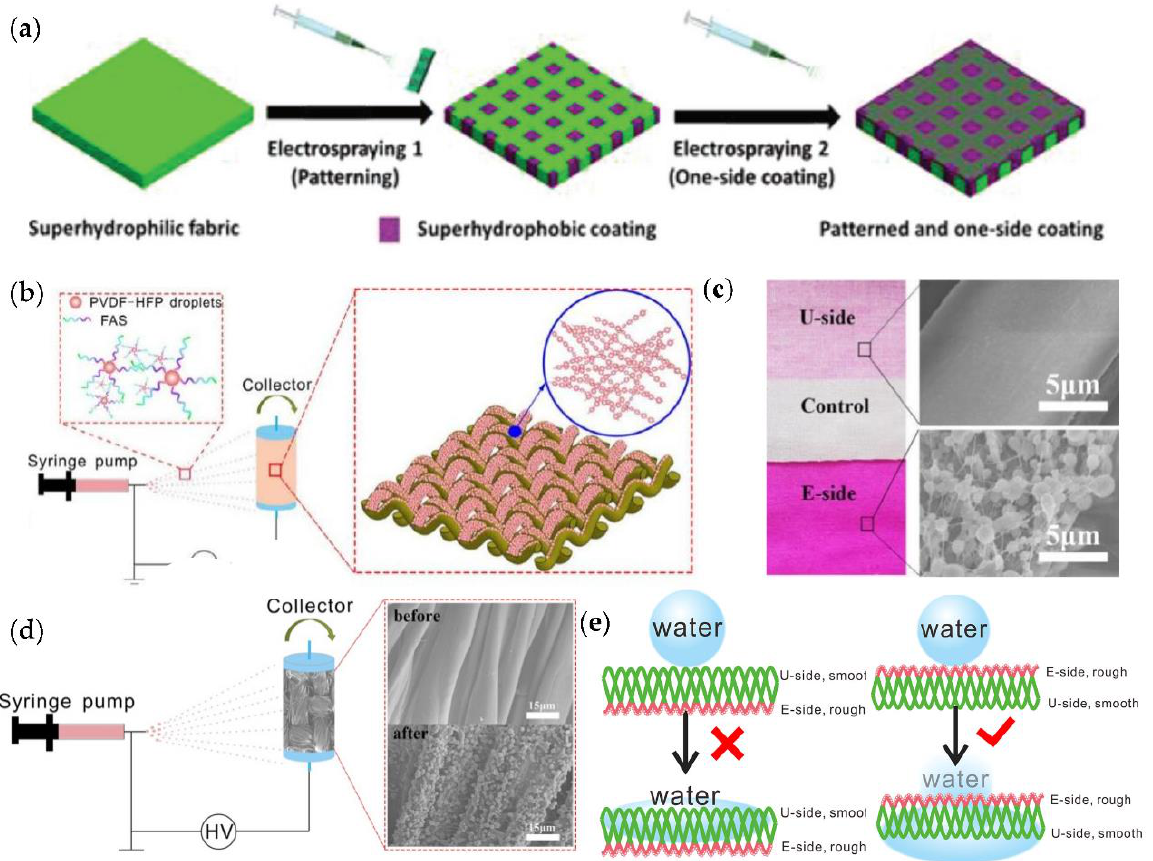
Figure 5. ( a ) Schematic illustration for the fabrication of a DWT fabric by the two-step electrospray treatment with patterning [41] (Copyright 2018, Wiley-VCH). ( b ) Schematic illustration for the preparation of UWT fabric by electrospraying coating. ( c ) Photos of the fabric before and after one-side electrospraying treatment (a pink dye was added into the coating solution to indicate